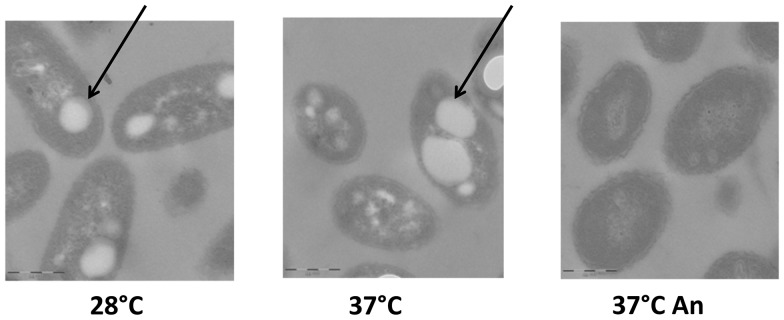
TEM observation of ultrathin sections of paraffin-embedded BtCDC272 grown in different conditions.Arrows point to PHA granules. The 1 μm scale bar is shown in the left bottom corner of each panel.